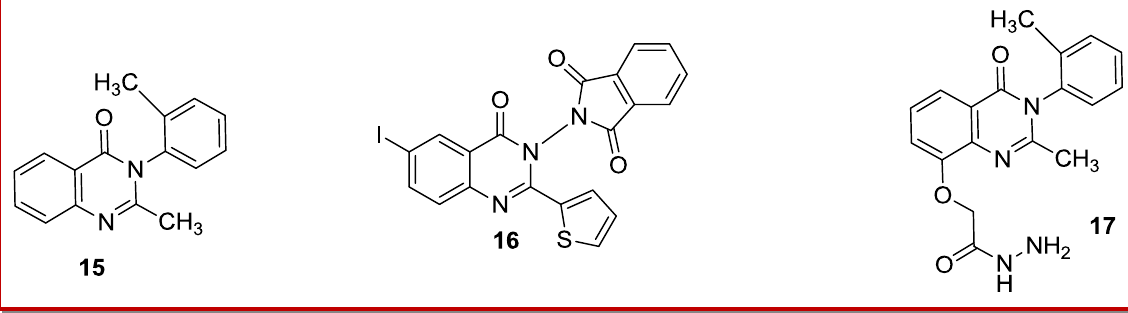
Figure 9: Some quinazoline motifs with anticonvulsant